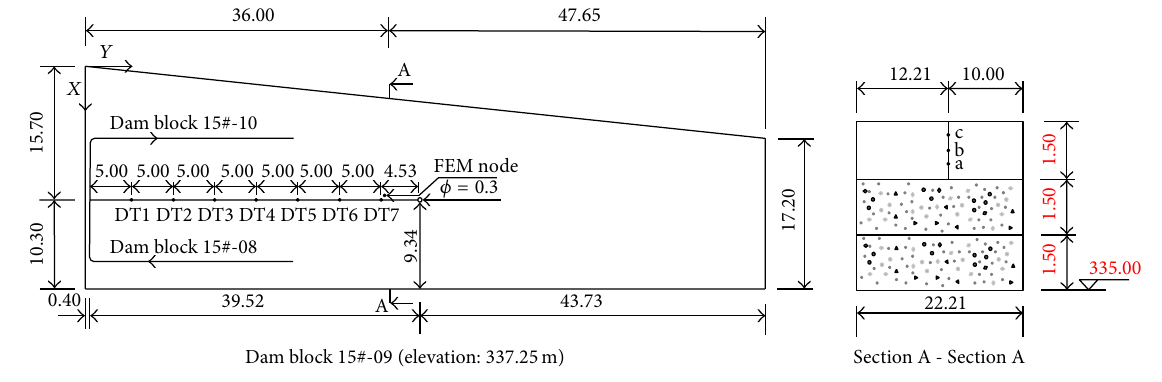
Figure 5: Position of cable and location of analysis nodes (unit: m). Table 3: Thermal and mechanical properties of materials.